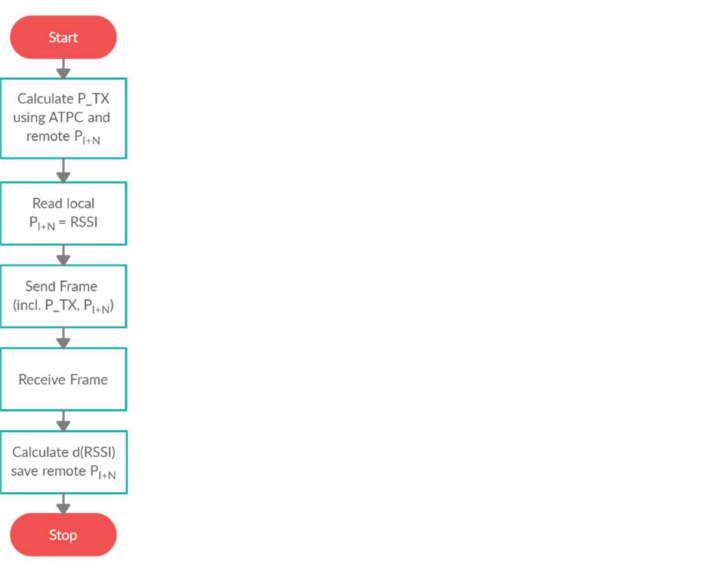
Figure 5. Simplified algorithm for data exchange between radio effector and sensor.